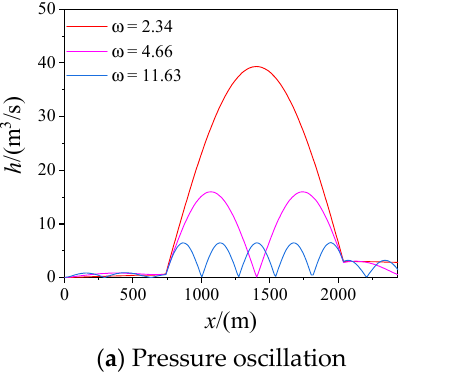
Figure 11. System’s response to the forcing function.